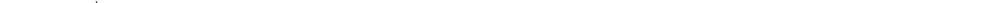
figure on next Fig. 3 1 H and HSQC NMR spectra of DHP ( a aromatic region; b : aliphatic region), and DHP- d ( c and e aromatic region; d and f aliphatic region) in DMSO- d 6 . The panels e and f are slices of c and d with a lower threshold, respectively. The dashed squares are 1 H NMR spectra are shown in the same magnification normalized with the solvent peaks at 2.49 ppm. The blue cross-peaks are in-phase signals, whereas the red peaks are anti-phase signals. Symbols in the HSQC spectra represent the assignments to respective substructures (A: β- O -4; A’: β- O -4/α- O -4; B: β-5; C: β–β; CA: cinnamyl alcohol), and subscripts (α, β and γ) indicate their position in the aliphatic chains. The symbol U indicates an unidentified